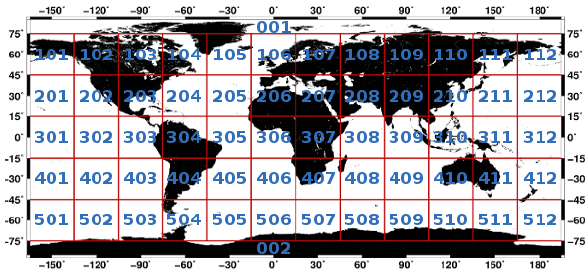
Fig. 9. Predefined world regions used by the SACS notification sys- tem and the monitoring service.